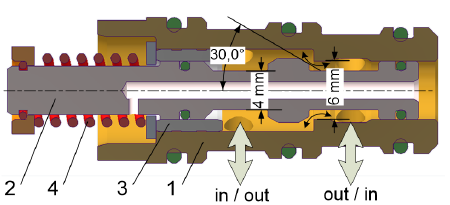
Figure 4. NO type seat valve; 1—body, 2—poppet, 3—sleeve, 4—spring.